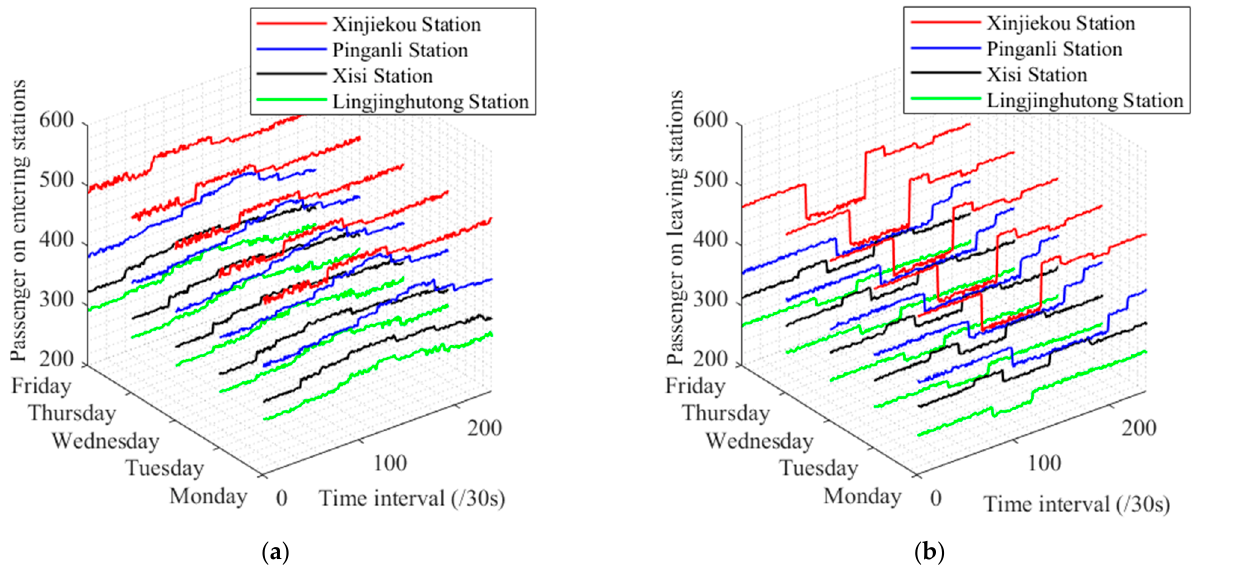
Figure 5. Distribution of passenger flow changes under different days: ( a ) passenger flow entering stations on different days; ( b ) passenger flow leaving stations on different days.